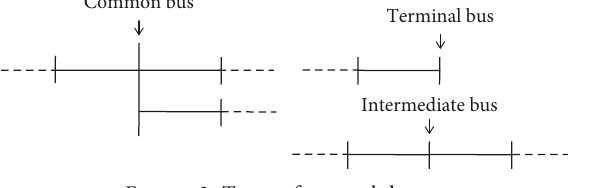
Figure 2: Single line diagram.